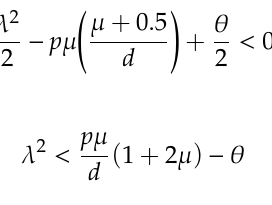
Figure 7. Sensitivity analysis for Q when input parameters change.